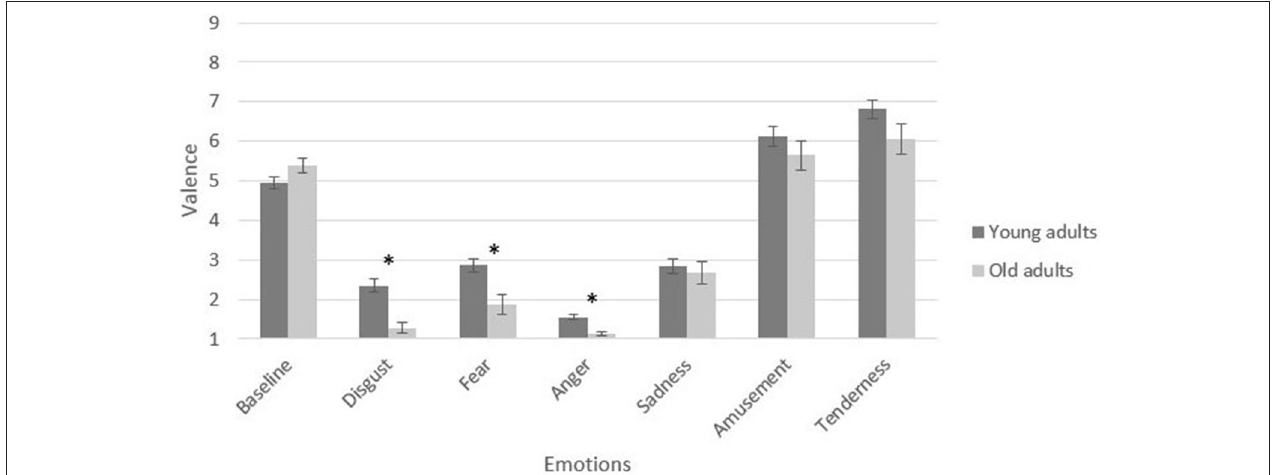
FIGURE 2 | Self-reported valence of participants by film condition and age group. Participant-level means of baseline and emotional target categories. Error bars depict standard error (SE) values. * p < 0.05.